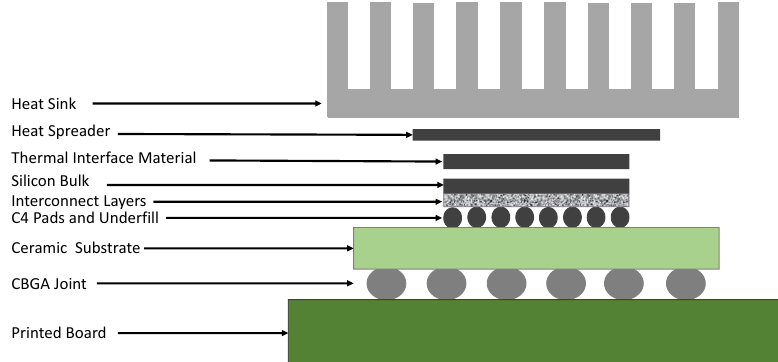
Figure 6. Stacked layers in a typical ceramic ball grid array (CBGA) package (adapted from Figure 2 in [37]).